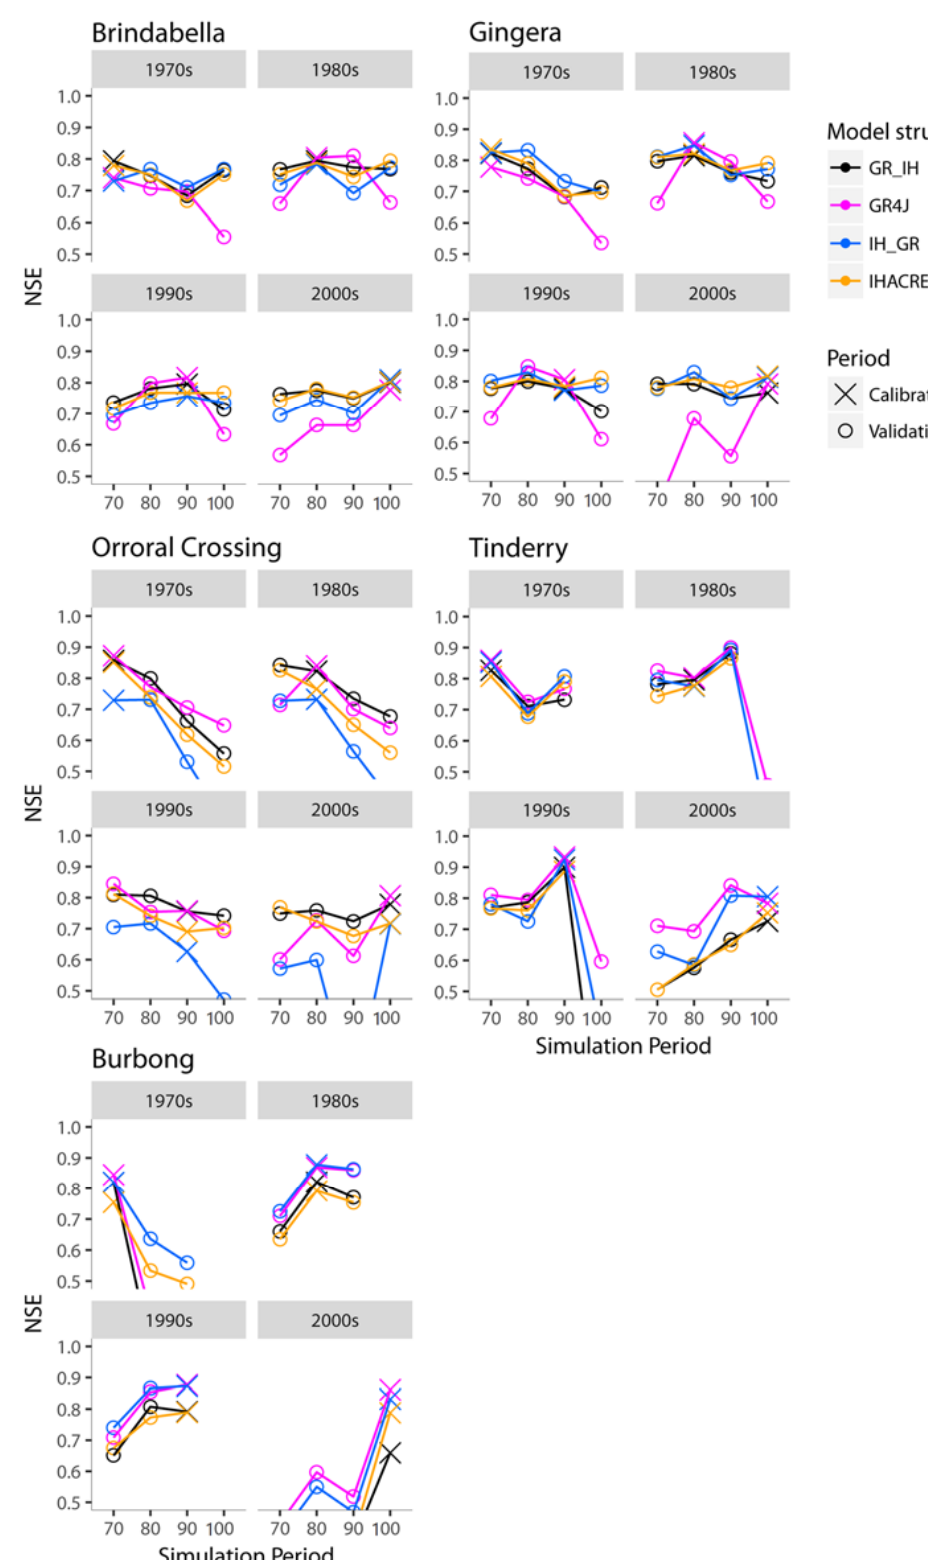
Figure 1. Comparison of the NSE values of the four rainfall – runoff models for the five catchments: Brindabella (wet), Gingera (wet), Orroral Crossing (intermediate), Tinderry (dry), and Burbong (dry).